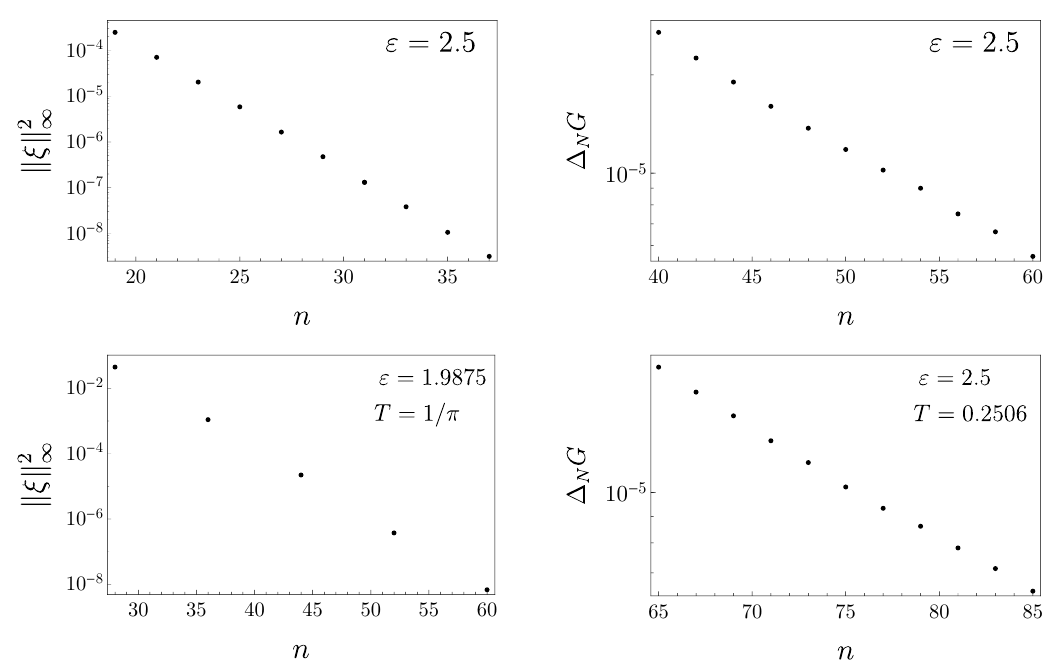
Figure 21 . Top left : log-linear plot of the DeTurck norm squared for the dominating soliton branch, at " = 2 : 5. Straight line indicates exponential convergence. Top right : log-linear plot of the relative error in the free energy G vs the grid size n , for the same data set as top left. Bottom left : log-linear plot of the DeTurck norm squared vs grid size for a large black hole with T = 1 =(cid:25) and " = 1 : 9875. Bottom right : log-linear plot of (cid:1) N G against n , for a cold ( T = 0 : 2506), small black hole, upper small branch ( " = 2 : 5).